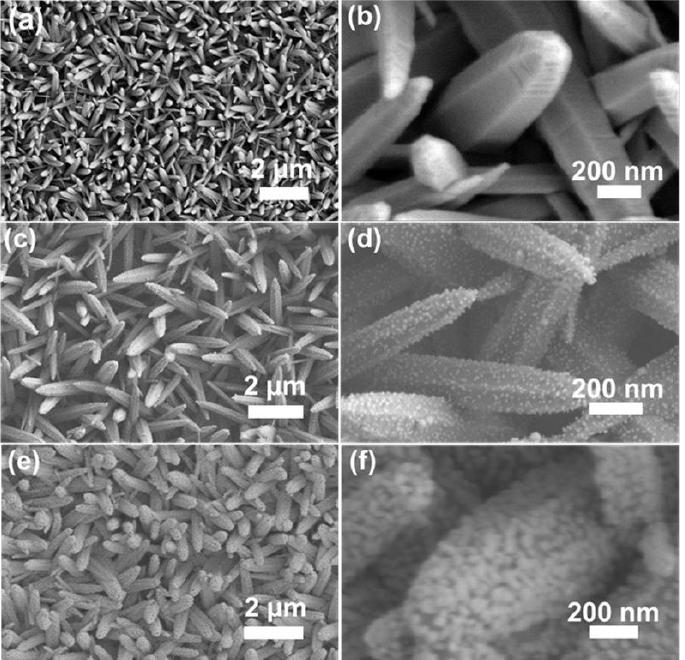
Figure 1. Morphology characterization. ( a ) SEM image of ZnO NR arrays. ( b ) The enlarged view of ( a ). ( c ) SEM image of ZnO NR arrays decorated with Ag seeds. ( d ) The enlarged image of ( c ). ( e ) SEM image of Ag/ZnO NR arrays. ( f ) The enlarged view of ( e ).